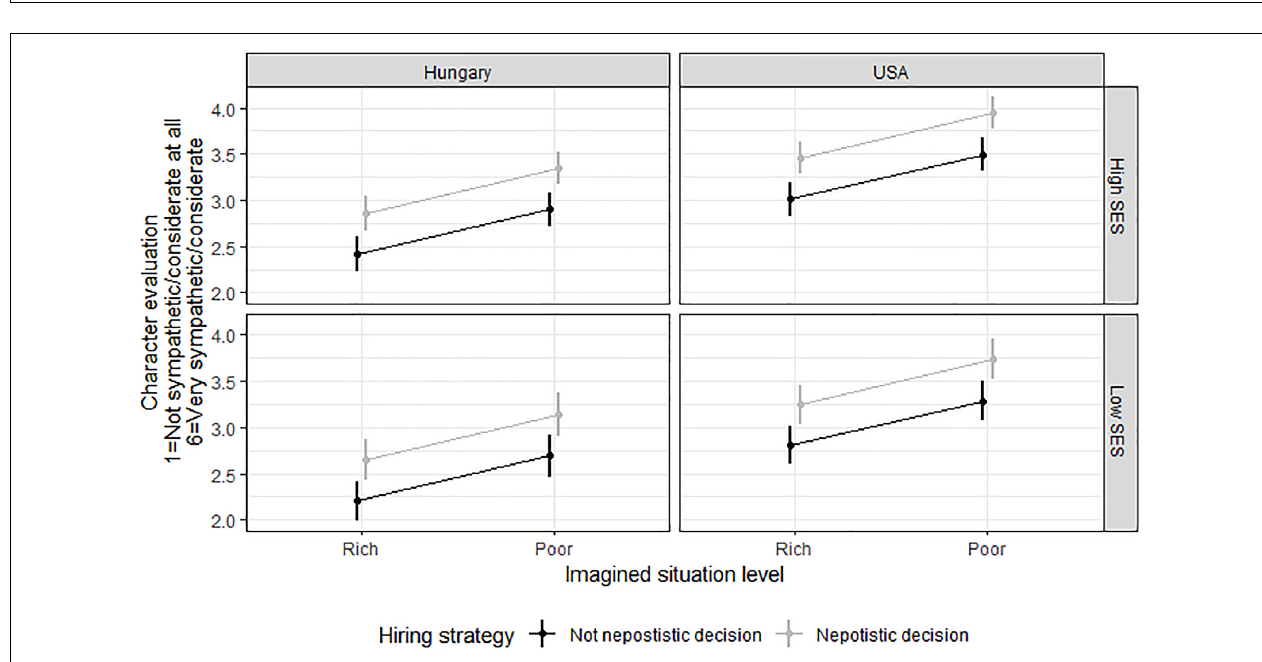
FIGURE 2 | Positive Character Evaluation of a Nepotistic Person. For the sake of simplicity, “High” and “Low” SES within each culture was based on a median split of MacArthur ladder data (Med = 6). The cultural, SES, imagined situational and hiring strategy (nepotistic vs. non-nepotistic) differences are significant.